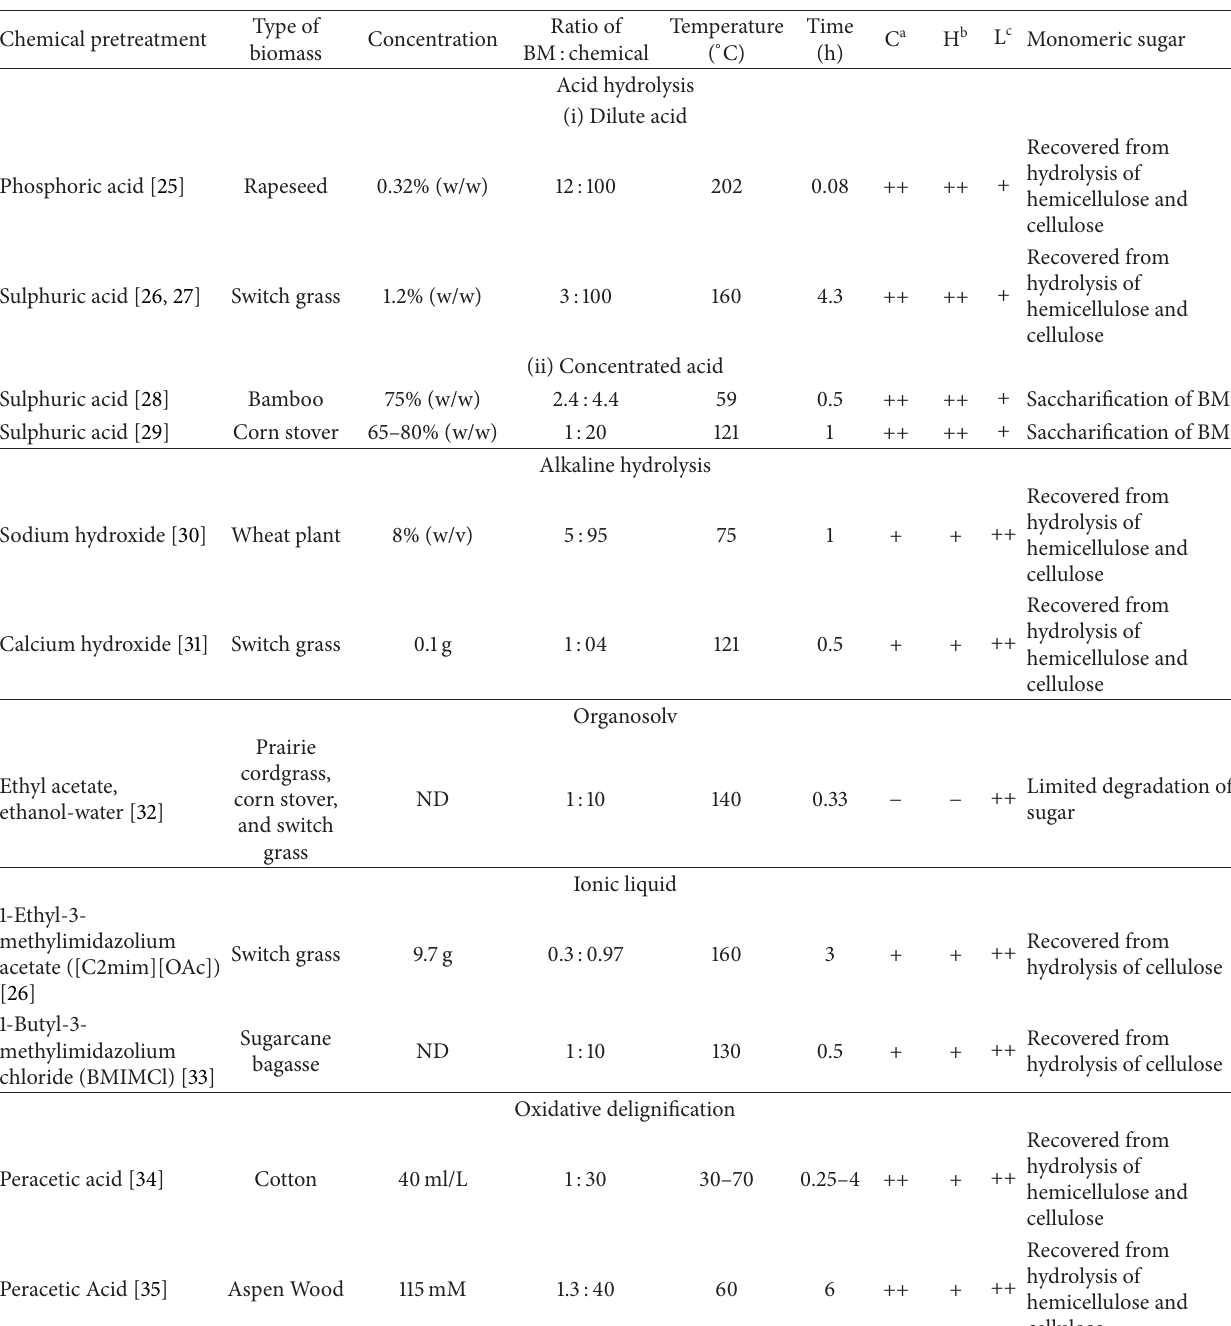
Table 2: Degree of biomass degradation by using various types of chemical